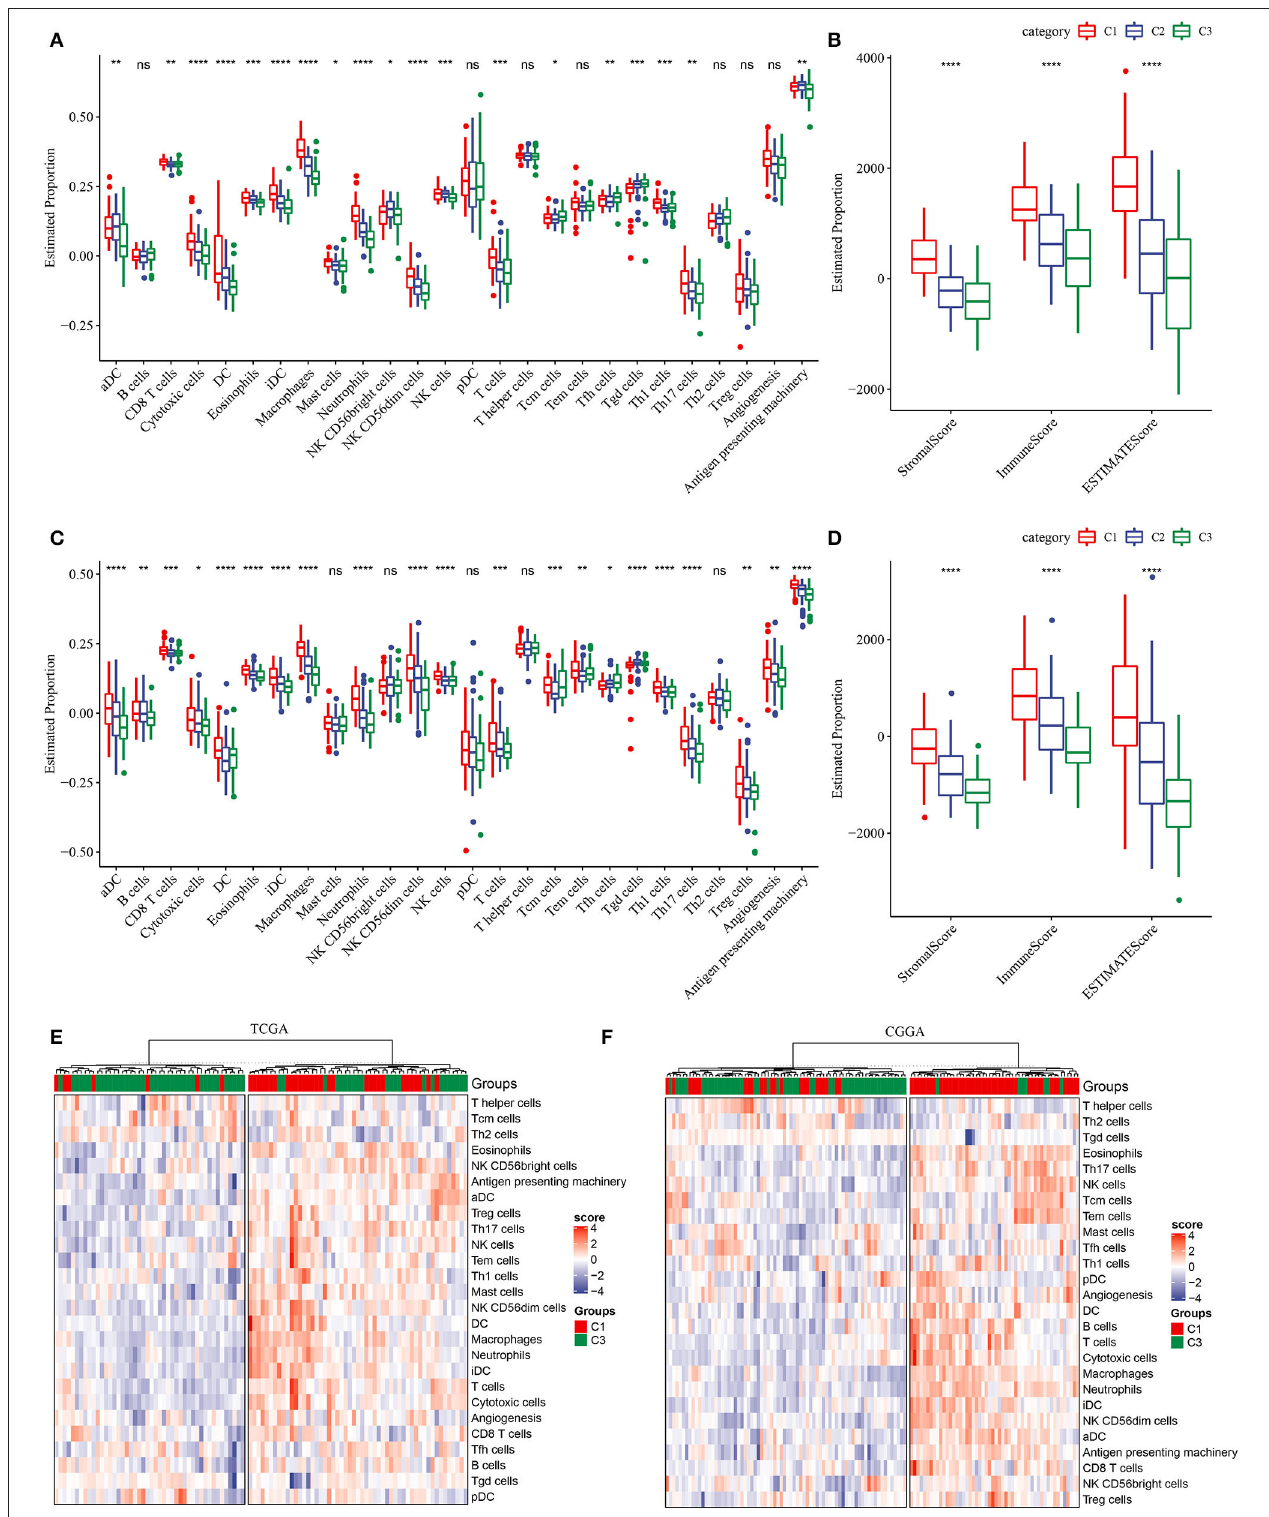
FIGURE 4 | Description of tumor microenvironment (TME) in three subtypes. (A) Estimated proportion (ssGSEA score) of immune cells through GSEA in TCGA-GBM dataset. (B) Stromal score and immune score of three subtypes calculated by ESTIMATE in TCGA-GBM dataset. (C) Estimated proportion (ssGSEA score) of immune cells through GSEA in CGGA-GBM dataset. (D) Stromal score and immune score of three subtypes calculated by ESTIMATE in CGGA-GBM dataset. (E,F) Unsupervised consensus clustering of immune cells for C1 and C3 subtypes. The Kruskal–Wallis test was conducted. ns, no significance. * p < 0.05, ** p < 0.01, *** p < 0.001, **** p <